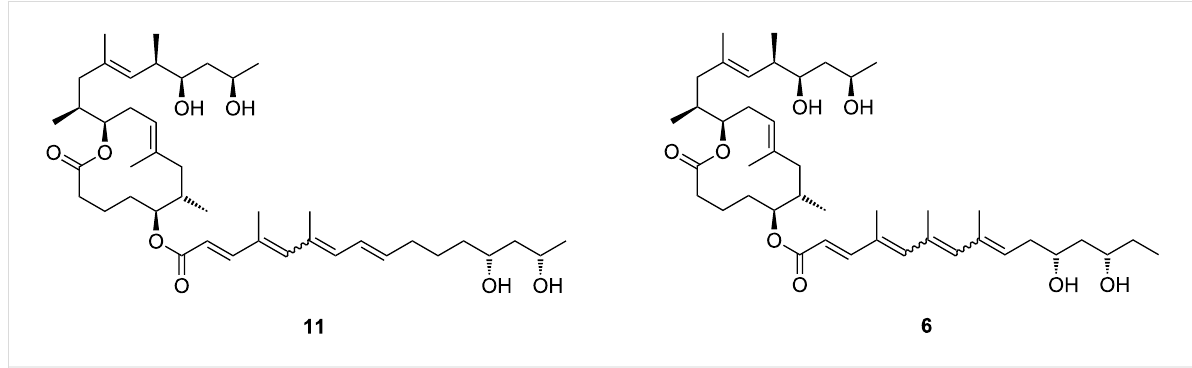
Figure 3: Misassigned mycolactone E structure according to Small et al. [50] ( 11 ) and the correct structure ( 6 ) first proposed by Leadlay et al. [56].